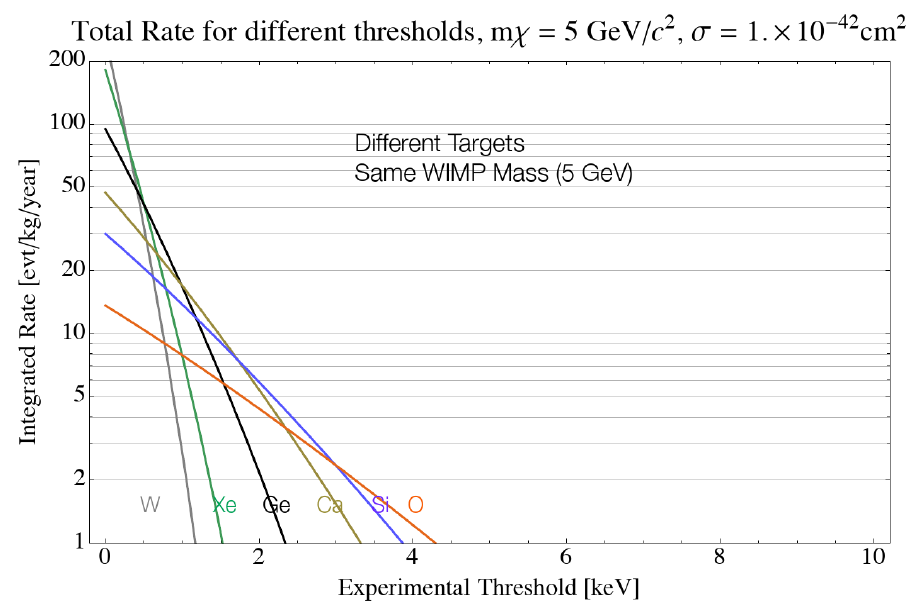
Figure 9: Event rates in units of counts per kg of material per year of data-taking vs. energy threshold in keV for different materials. The WIMP mass is fixed at 5 GeV / c 2 . Figure courtesy of Enectali